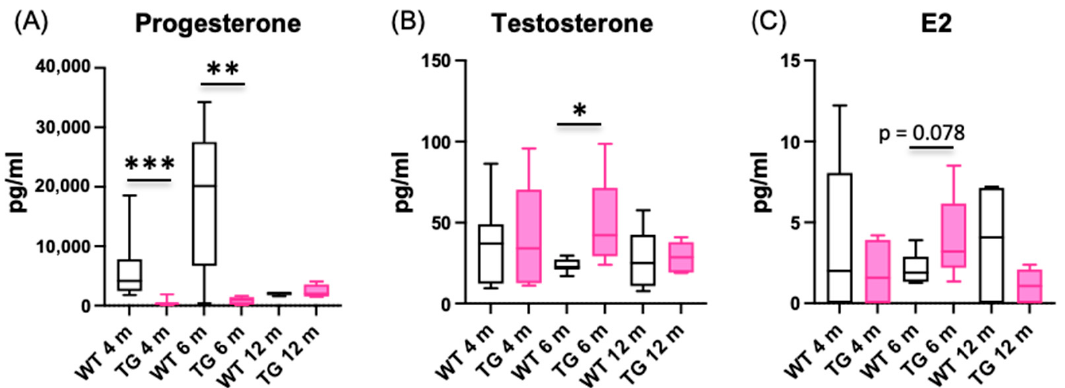
Figure 5. Serum hormone concentrations. Serum hormone concentrations were measured at the ages of 4, 6 and 12 months. ( A ) Serum progesterone level was significantly reduced at the ages of 4 and 6 months in HSD17B1TG females. ( B ) The concentration of serum testosterone was significantly increased in HSD17B1TG females at the age of 6 months. ( C ) There was no difference in serum E2 concentration in any time point. E2 = estradiol; 4 m WT n = 11, 4 m HSD17B1TG n = 7, 6 m WT n = 9, 6 m HSD17B1TG n = 5, 12 m WT n = 5, 12 m HSD17B1TG n = 7; * p < 0.05, ** p < 0.01, *** p < 0.001.